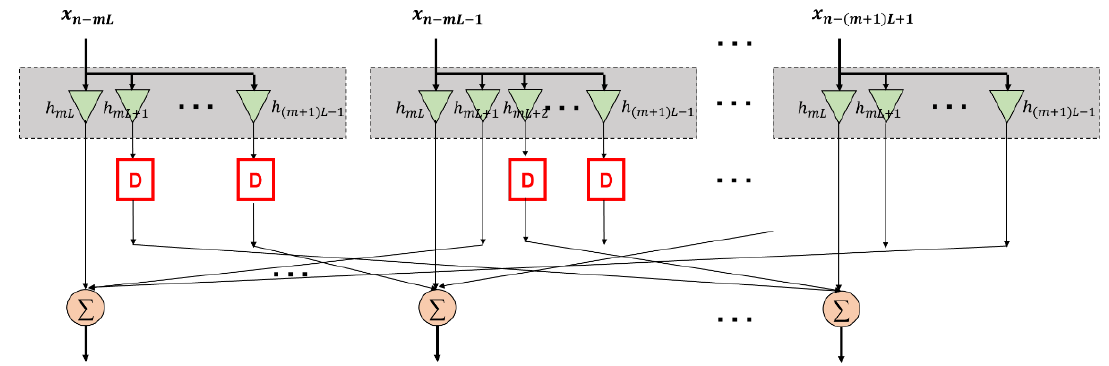
(b) Figure 4. Implementation of the time block, 𝑇𝐵 𝑚 , with the corresponding two terms in (7) : ( a ) the form term and ( b ) the latter term. Here, it should be mentioned that there are 2𝐿 − 1 data inputs that are multiplied with the corresponding coefficients ( 𝐻 𝑚 ) in each time block ( 𝑇𝐵 𝑚 ) . Among the 2𝐿 − 1 dif- ferent input samples, if the 𝐿 samples { 𝑥 𝑛−𝑚𝐿 , 𝑥 𝑛−𝑚𝐿−1 , … , 𝑥 𝑛−(𝑚+1)𝐿+1 } are the inputs in the current clock cycle, the other 𝐿 − 1 ones { 𝑥 𝑛−(𝑚+1)𝐿 , 𝑥 𝑛−(𝑚+1)𝐿−1 , … , 𝑥 𝑛−(𝑚+2)𝐿+2 } are ob- tained in the previous clock cycle. Since in transposed form, every input sample should be multiplied with all the coefficients to generate the intermediate tap products, we can conduct the multiplication firstly and then save the products in registers for later addition. By doing this, intermediate products can be reused at the cost of several additional regis-